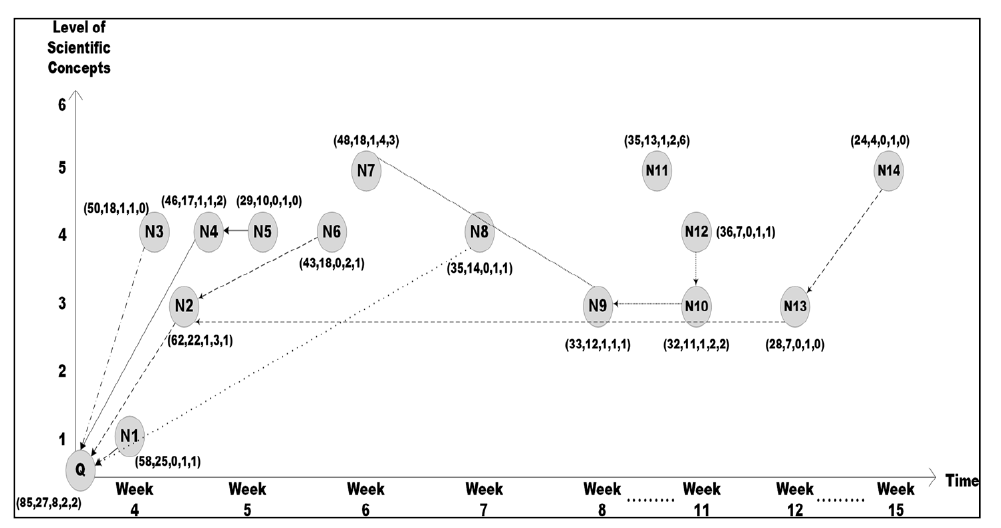
Figure 1 : Chronologie des notes postées sur le forum KF [12] (p.